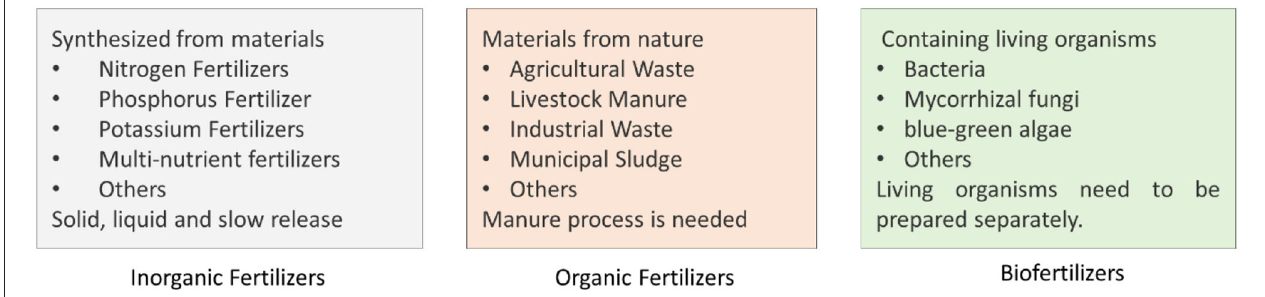
FIGURE 2 | Three types of fertilizers. Three types of fertilizers based on different criteria are shown. Biofertilizers will be playing important roles in sustainable agriculture due to the advantages to sustain the ecosystem of soil and improving growth of the